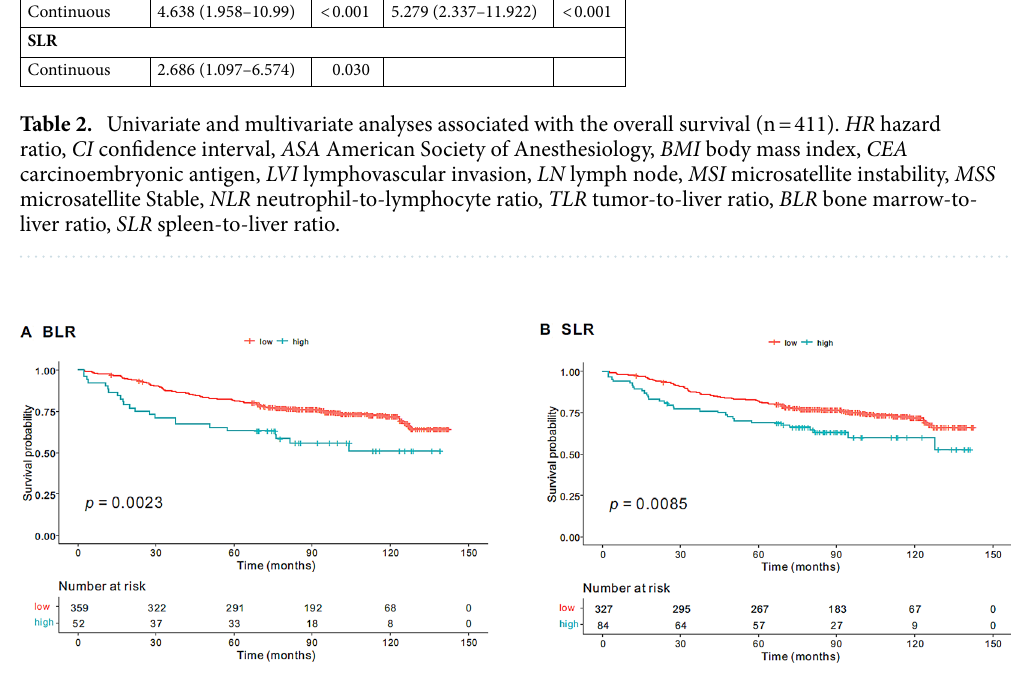
Figure 1. Kaplan–Meier curves of overall survival stratified, according to BLR ( A ) and SLR ( B ).